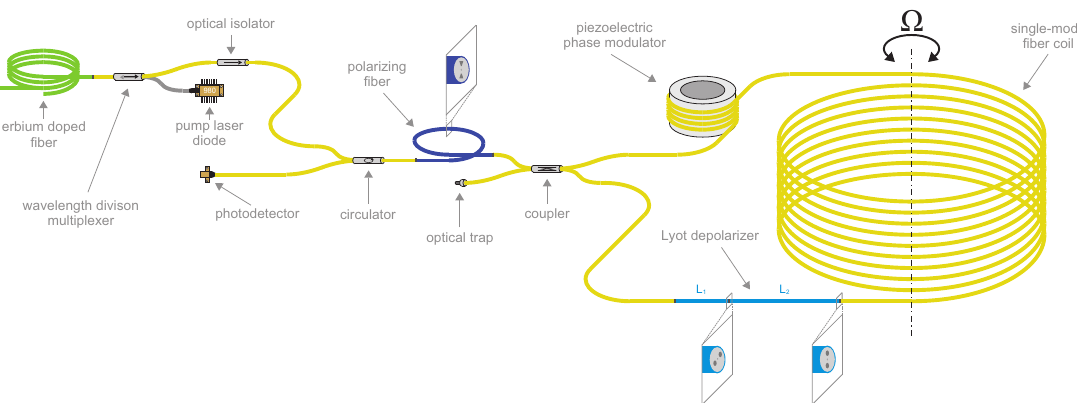
Figure 3. The optical architecture of the single-mode I-FOG setup for the PEM-based closed-loop method testing.